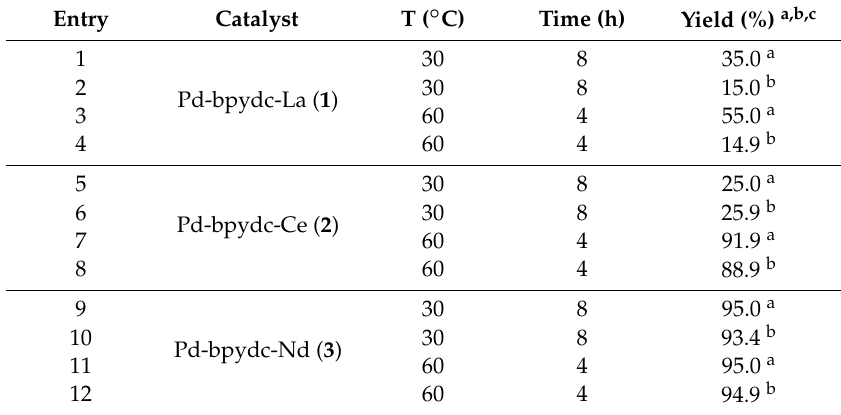
Table 1. Suzuki–Miyaura cross-coupling of 4-bromoanisole with phenylboronic acid in methanol-induced by Pd-bpydc-Ln catalysts 1 – 3 .